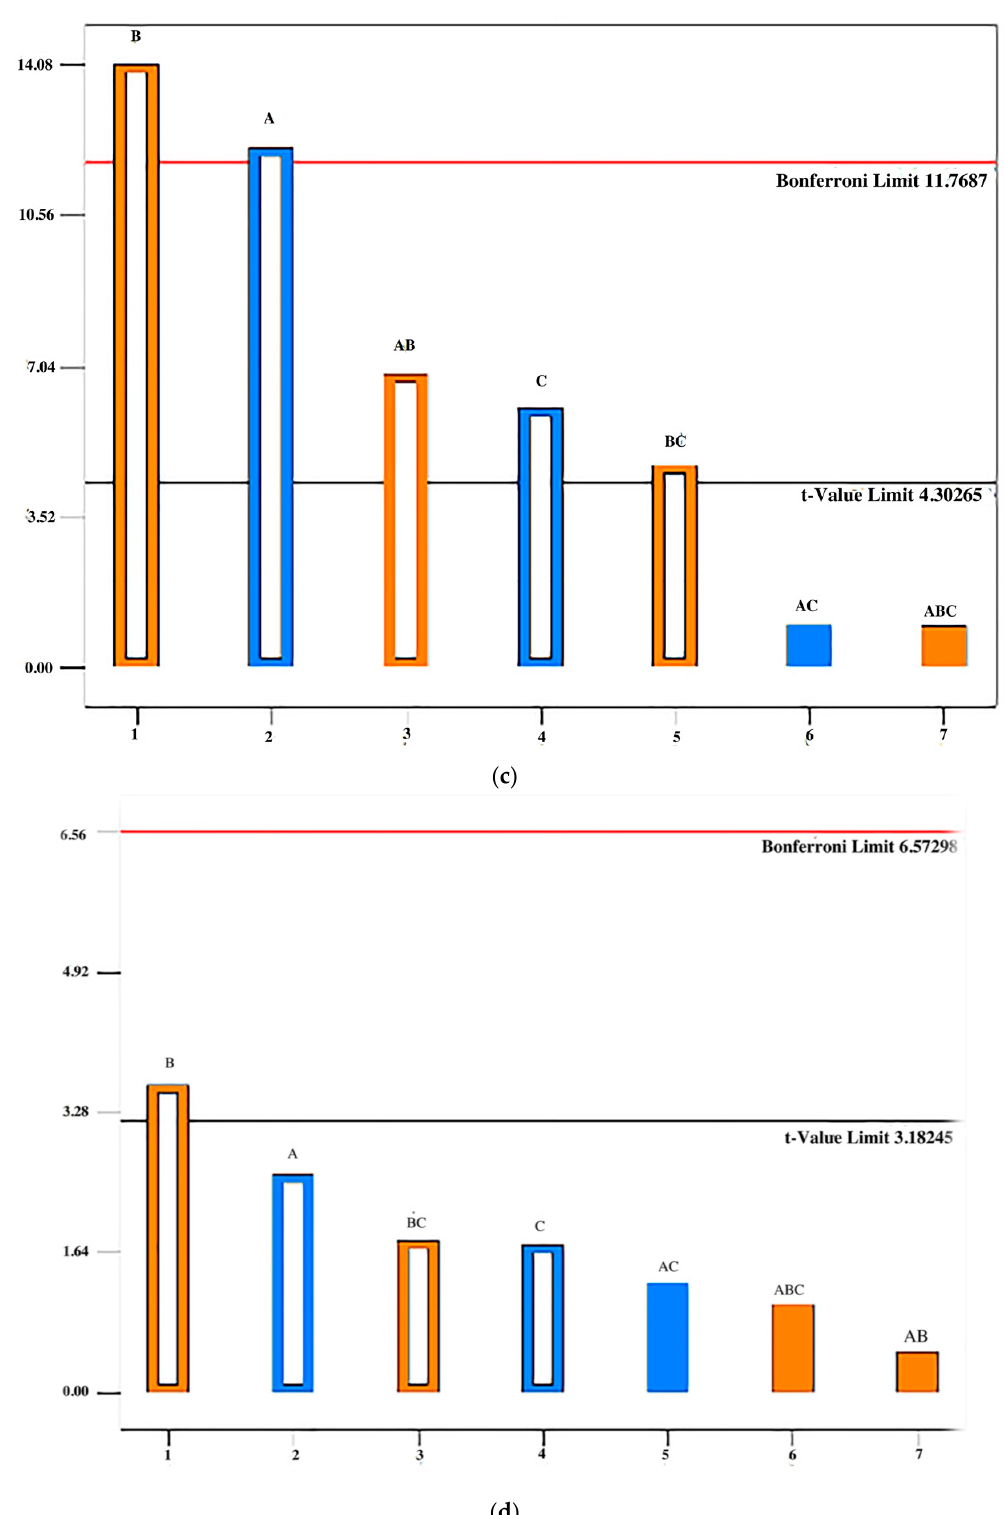
Figure 8. Influence of formulation components on LMT dissolution rate in 15 min in pH 6.8 dissolution medium after exposure to ( a ) high humidity conditions, ( b ) low humidity conditions; dissolution medium pH 1.2 after exposure, ( c ) high humidity conditions and ( d ) low humidity conditions. A (type of filler), B (NaSG), C (MgST).